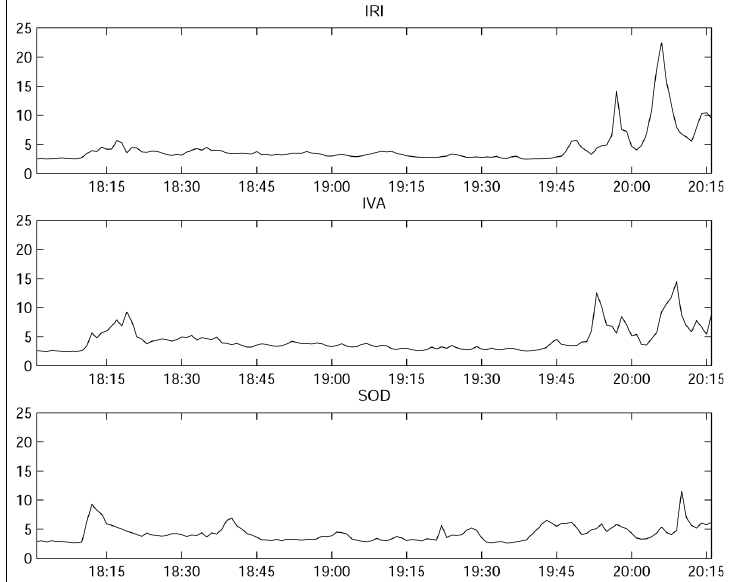
Fig. 6. The integrated intensity of opti- cal auroras (in arbitrary units) as a func- tion of UT in the regions of the riometer beams at IRI, IVA, and